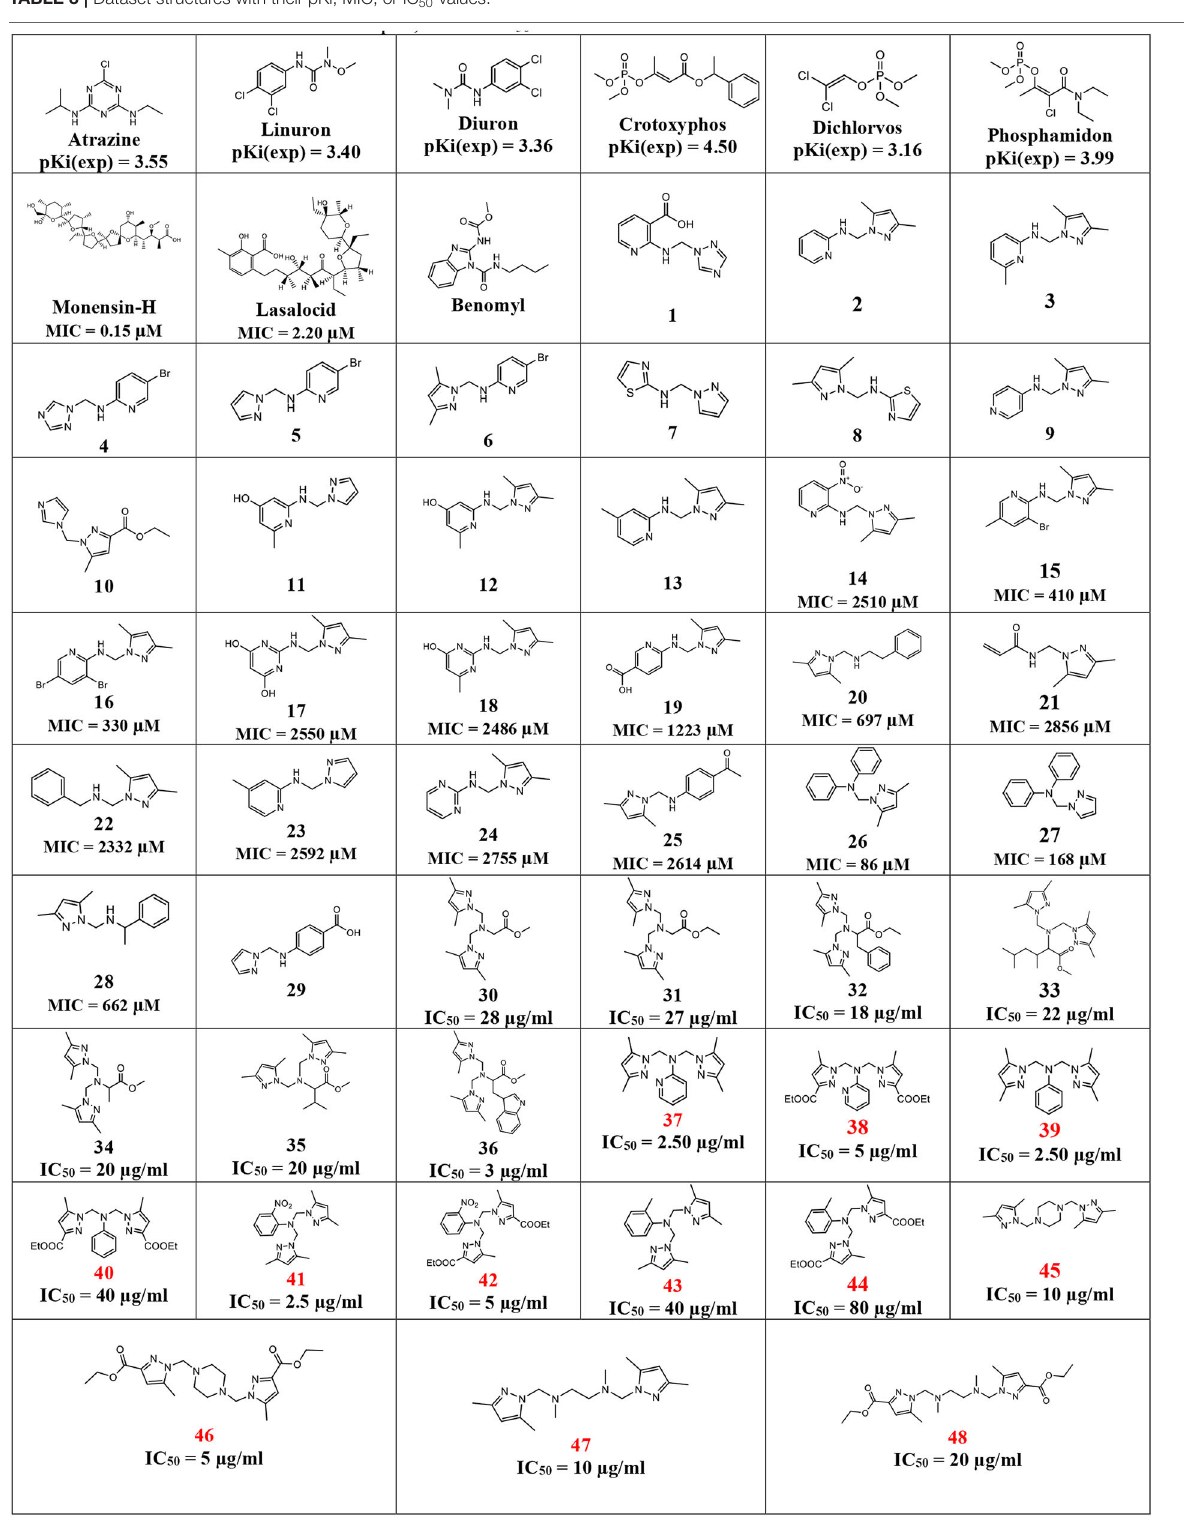
TABLE 3 | Dataset structures with their pKi, MIC, or IC 50